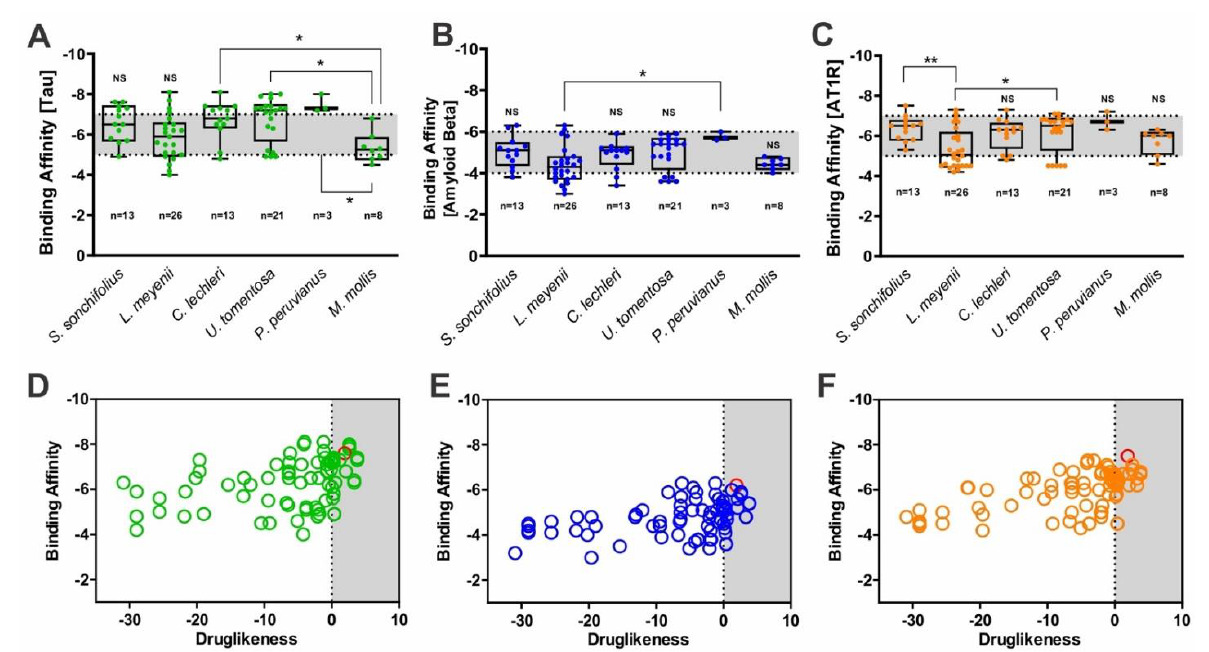
Figure 1. Binding affinities of molecules screened from Smallanthus sonchifolius, Lepidium meyenii, Croton lechieri, Uncaria tomentosa, Physialis perivianus , and Minthostachys mollis against: ( A ) tau peptide, ( B ) amyloid beta (1–40), and ( C ) AT1R. NS: not significant. * p < 0.05 and ** p < 0.0.1 significance among groups. Box plots with minimum and maximum values of binding affinities. Scatter plot showing binding affinity versus drug-likeness score for: ( D ) tau, ( E ) amyloid beta (1–40), and ( F ) AT1R.